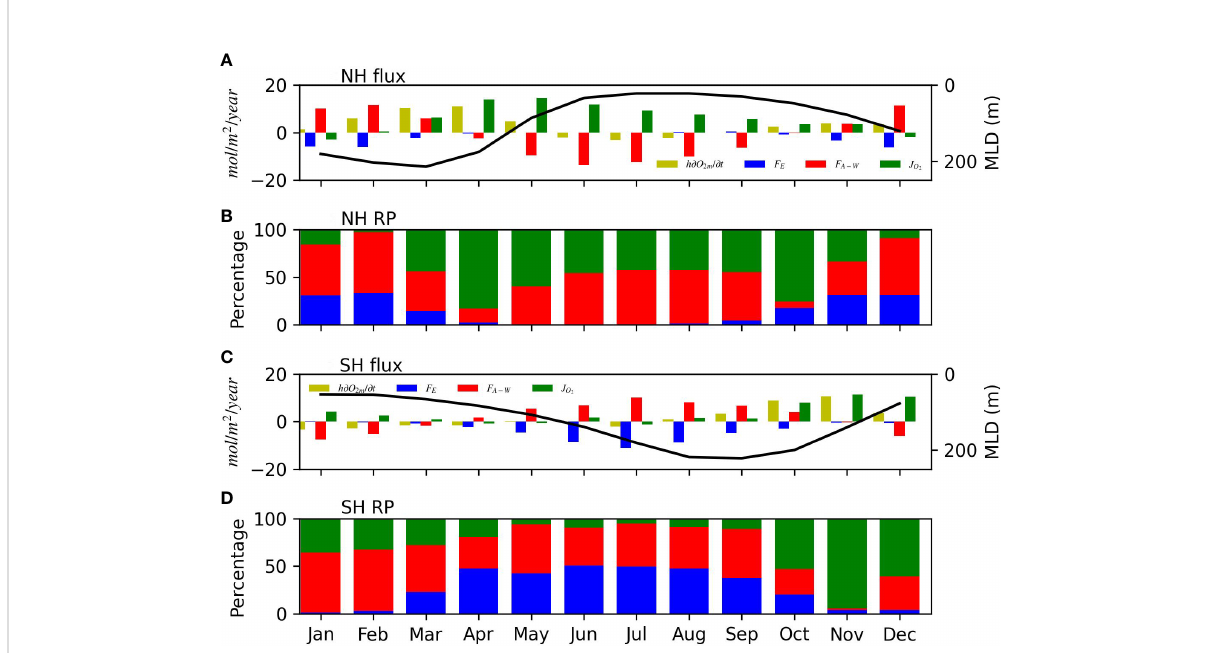
FIGURE 5 (A) Monthly bar-chart of the four terms in Eq. (2) for the Northern Hemisphere (NH) between 30°N and 70°N. This is a replot of the monthly time series shown in Figures 4E – H. Superimposed black line is the average mixed layer depth between 30°N and 70°N to show the seasonality of the MLD with the four terms. (B) Relative percentage (RP) of the magnitude (absolute value) of the three terms on the right-hand side of Eq. (2) to show the relative importance of each term in controlling O 2 C change in each month in the NH between 30°N and 70°N. Blue: entrainment, red: air-sea fl ux, and green: “ biological ” oxygen production. (C) Monthly bar-chart of the four terms in Eq. (2) for the Southern Hemisphere (SH) between 30°S and 70°S. Similar notations are used as in (A) . (D) RP of the magnitude of the three terms in Eq. (2) between 30° S and 70°S. Similar notations are used as in (B)